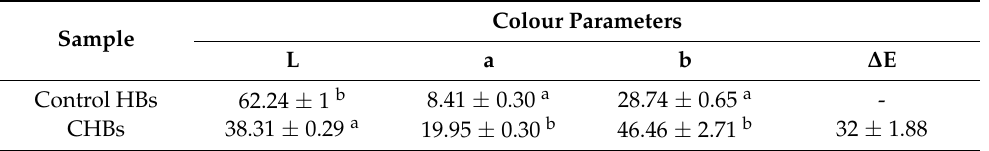
Table 1. Colour parameters of CHBs 1 .